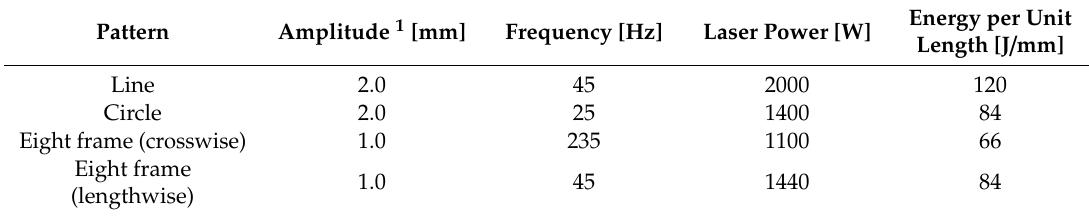
Table 3. Laser welding parameters selected for the investigation of gap bridging ability using beam oscillation (v s. = 1.0 m/min).